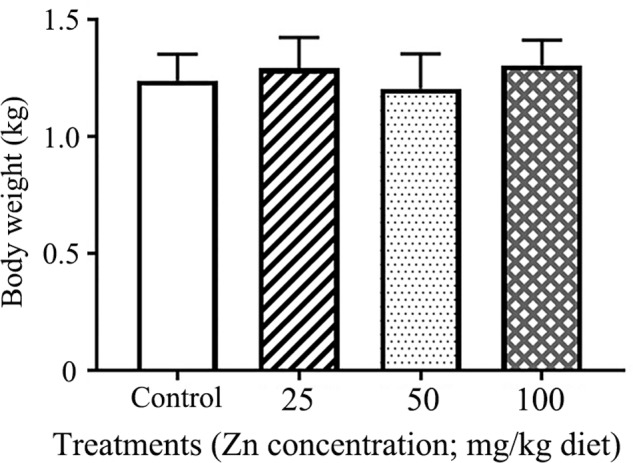
Effects of ZnO NP treatment on hen body weight. The Y-axis represents body weight (kg), and the X-axis represents the treatment group.